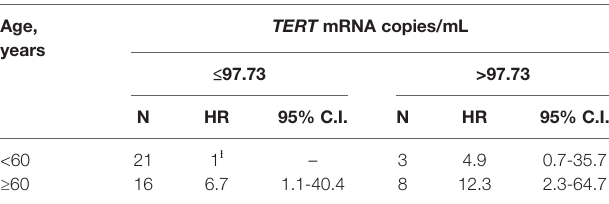
TABLE 4 | HR and 95%C.I. according to the combined effect of age and circulating TERT mRNA levels among 49 SOT patients. Age,